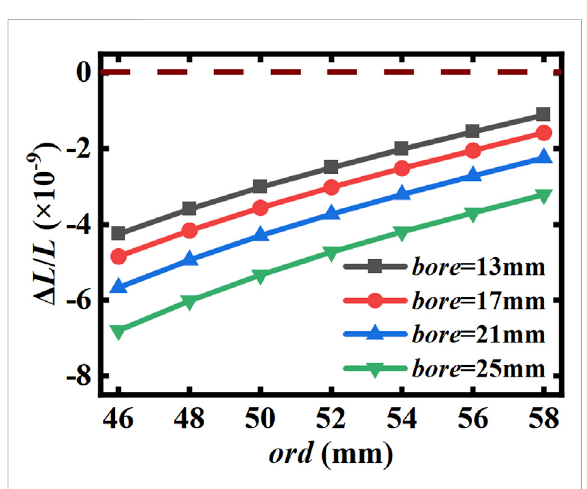
Figure 2C, the compensation temperature difference Δ T > 5 ° C